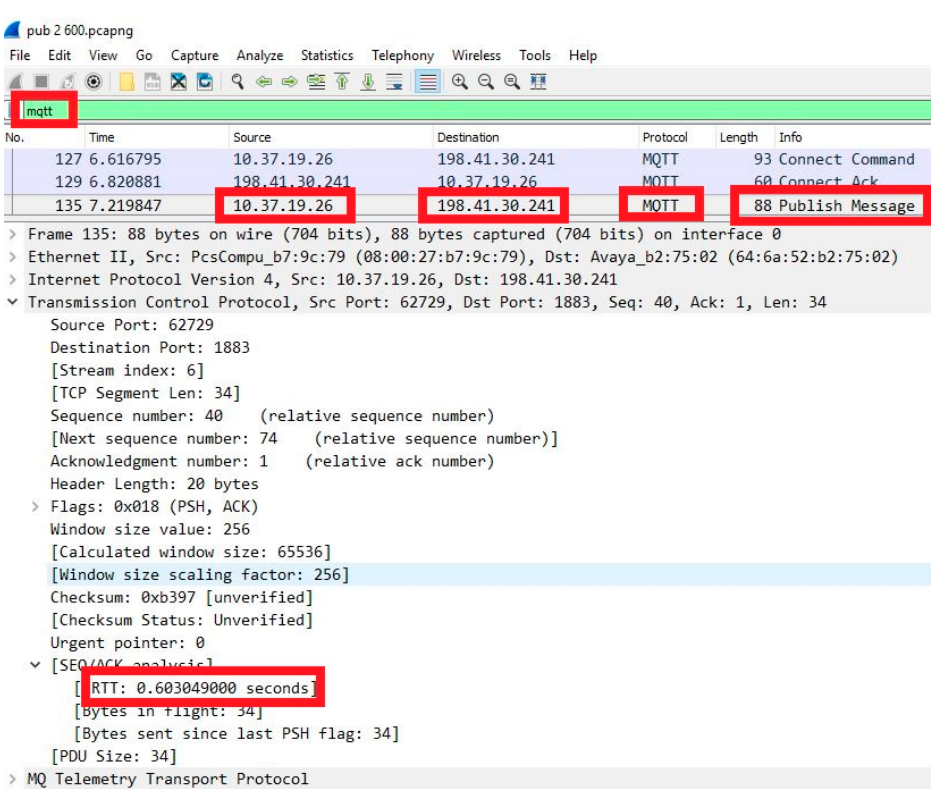
Figure 23. Communication delay implementation for case Bc.